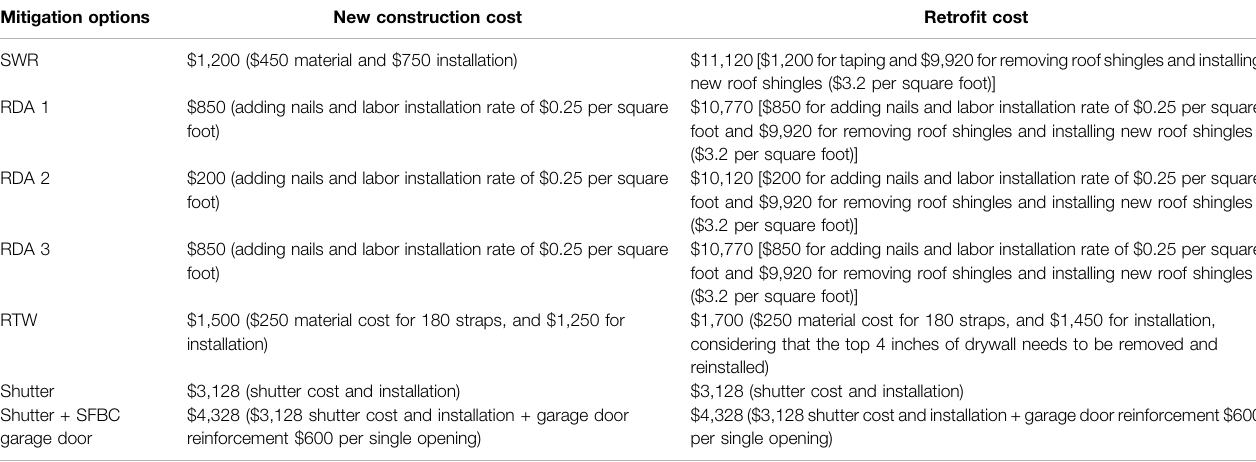
TABLE 3 | New and retro fi t construction cost for each mitigation strategy in a one-story residential building (adapted from Orooji and Friedland